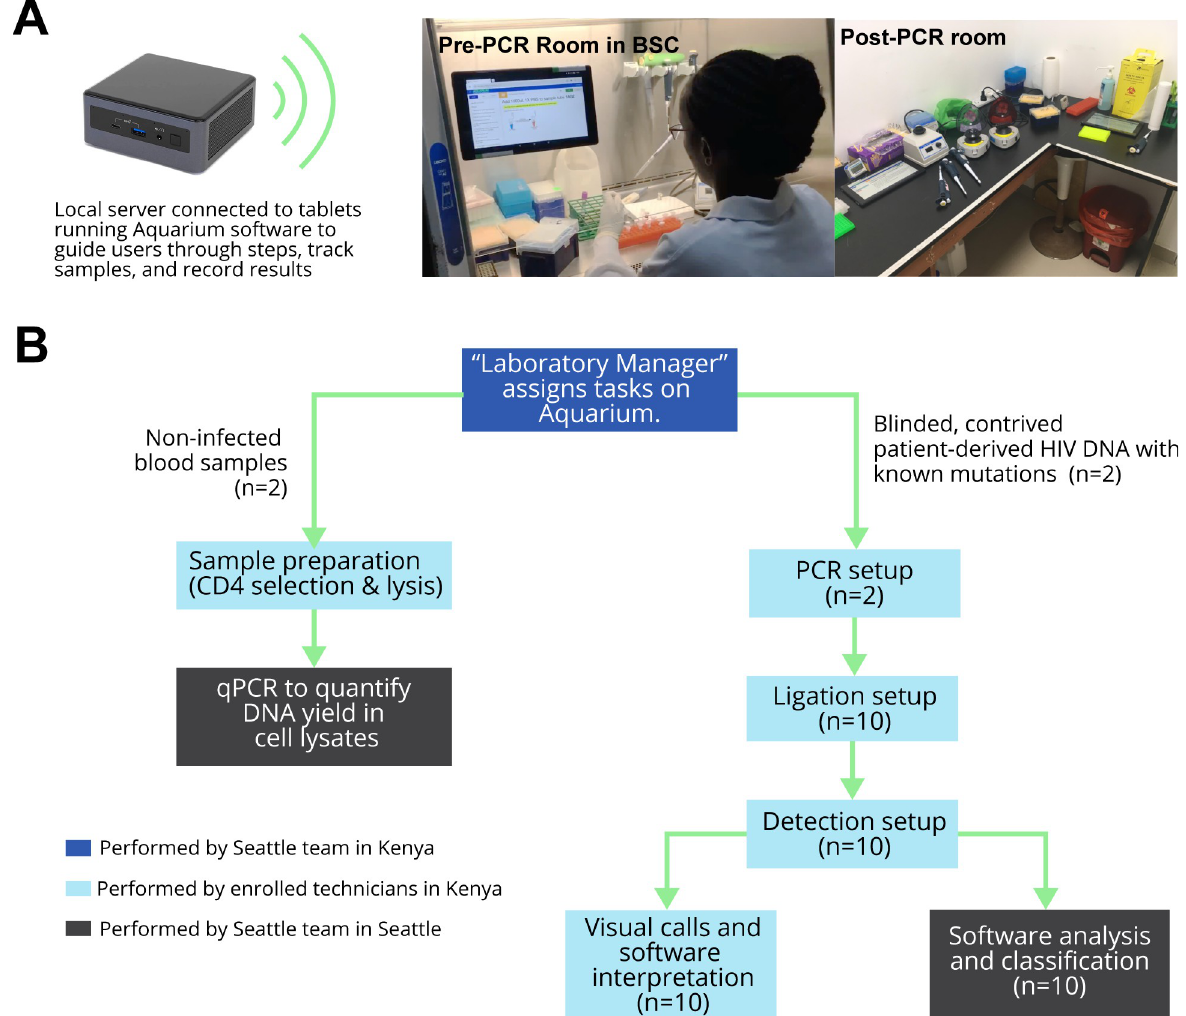
Fig 1. OLA-Simple laboratory setup and workflow. (A) Laboratory setup: Tablets were connected to a local server to run Aquarium software. The pre-PCR room had a refrigerator/freezer and a BSC where CD4+ separation and PCR reaction were set-up. Technicians controlled the Aquarium- based software on the tablet with a foot pedal (not shown in the picture) while performing CD4+ preparation. The post-PCR room had two designated bench areas to set up ligation and detection separately. This room also contained a thermal cycler and a scanner. (B) Tasks assigned by Aquarium for Kenyan technicians, and assessment of their performance using Aquarium-assisted OLA-Simple. The sample preparation module was separated from the amplification, ligation, detection, and interpretation module. Associated protocol code, and examples of complete runs are publicly available (https://github.com/OLA-Simple/Papers-Vrana-Panpradist-et-al-2021).